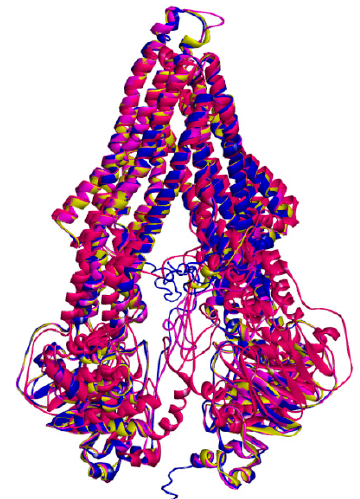
Figure 6. Superimposed protein structures of the h P-gp models generated and the crystal structure of m P-gp (PDB ID: 4M1M). The m P-gp is colored in yellow.